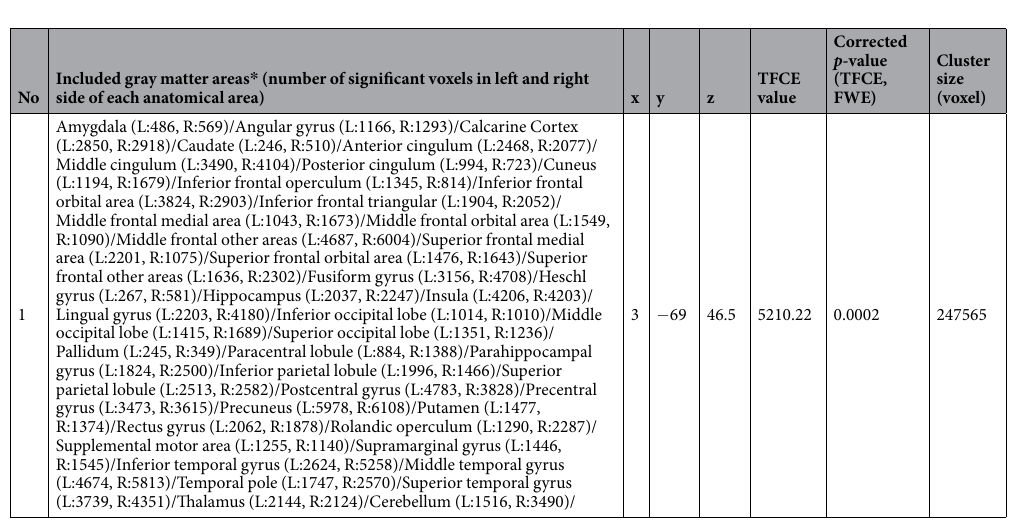
Table 5. Brain regions exhibiting significant correlations between TBIT spatial factor scores and